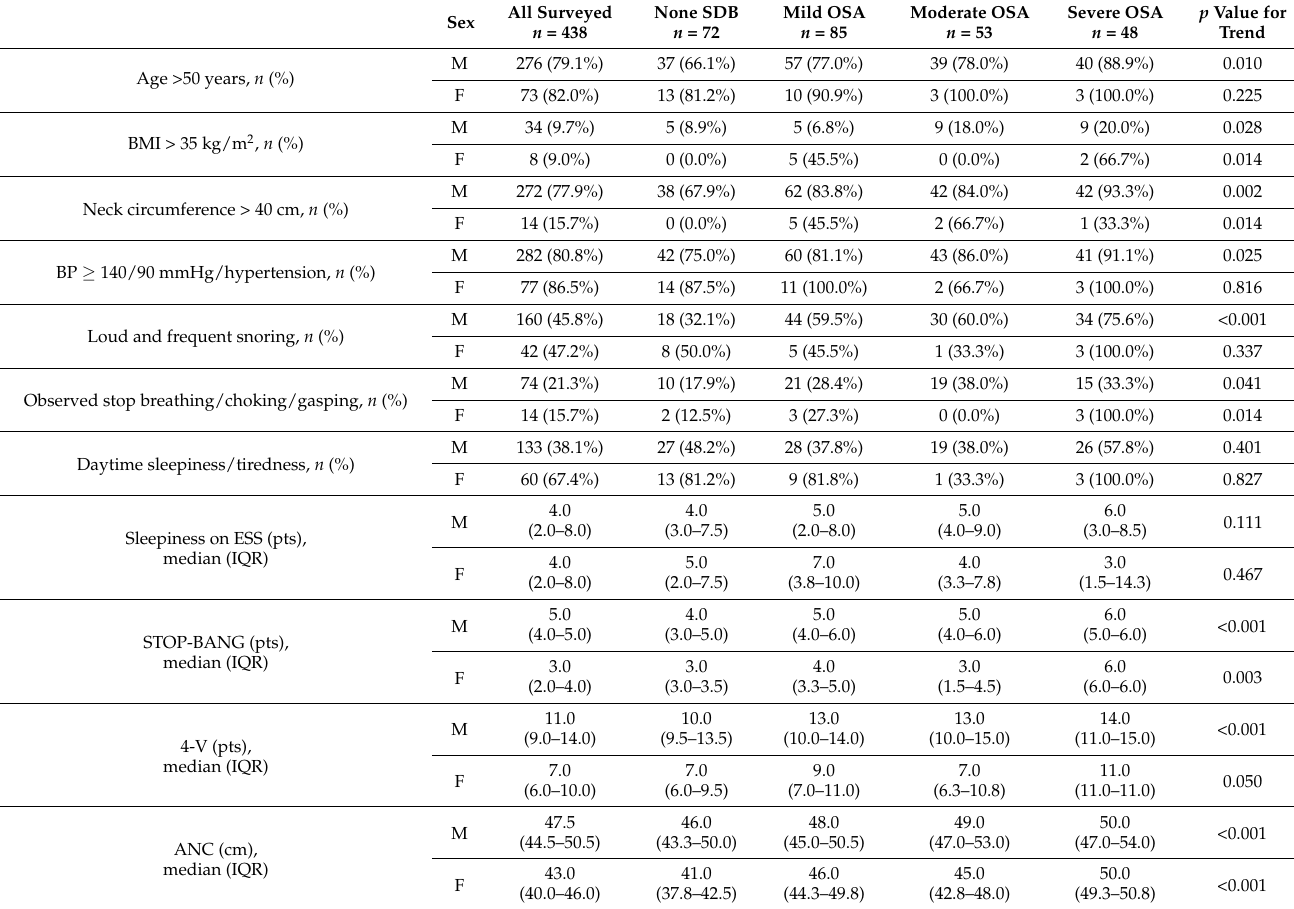
Table 4. The prevalence of risk factors and score on the risk scales in the entire study group and subgroups, depending on the severity of obstructive sleep apnea and sex.